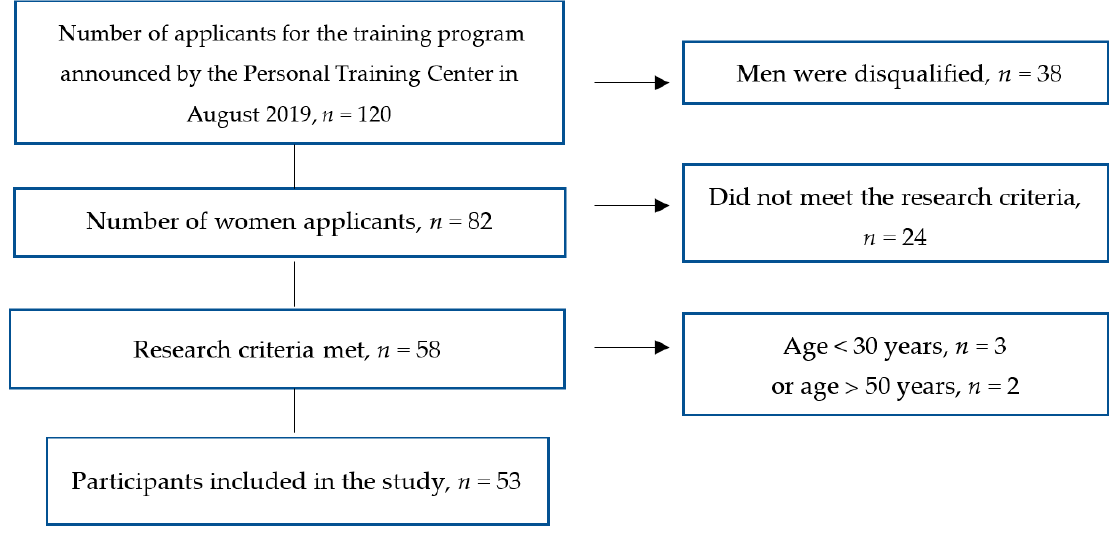
Figure 2. Flowchart showing the participant selection process.